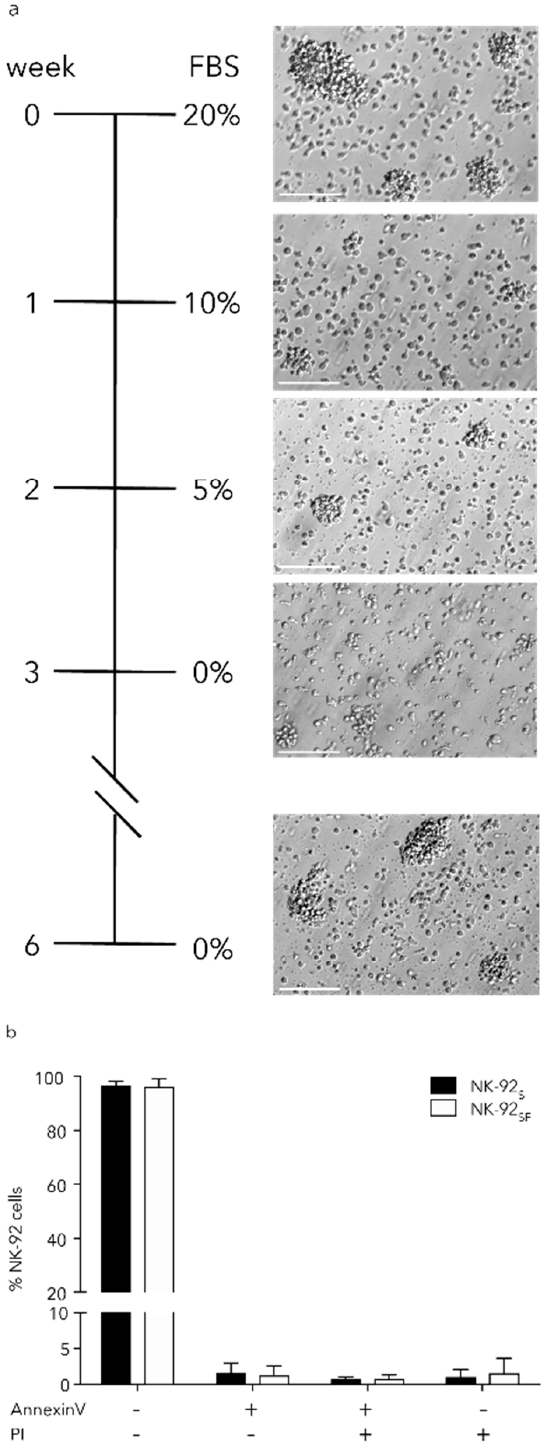
Figure 1. Serum-free culture of NK-92 cells does not affect colony formation and viability. ( a ) Schematic overview of the serum starvation process over four weeks following a three-week recovery phase. Microscope images of NK-92 cells during the starvation process. Scale bar equals 100 μ m. ( b ) Staining with Annexin V and propidium iodide (PI) of CD56 + NK-92 cells, after the 3-week recovery period, identified live cells (Annexin V − /PI − ), pre- (Annexin V + /PI − ) and pro-apoptotic (Annexin V + /PI + ) cells as well as necrotic cells (Annexin V − /PI + ). Each bar represents the mean (+SD) of eight independent assays performed in duplicates.